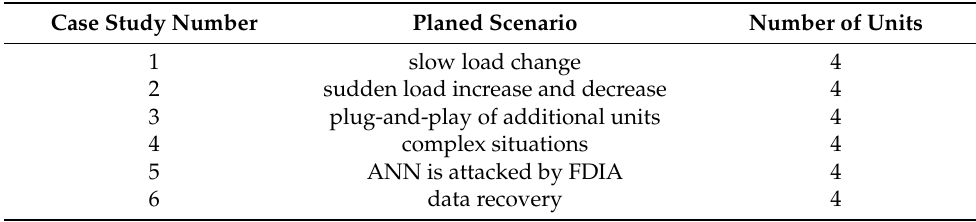
Table 1. Case Study